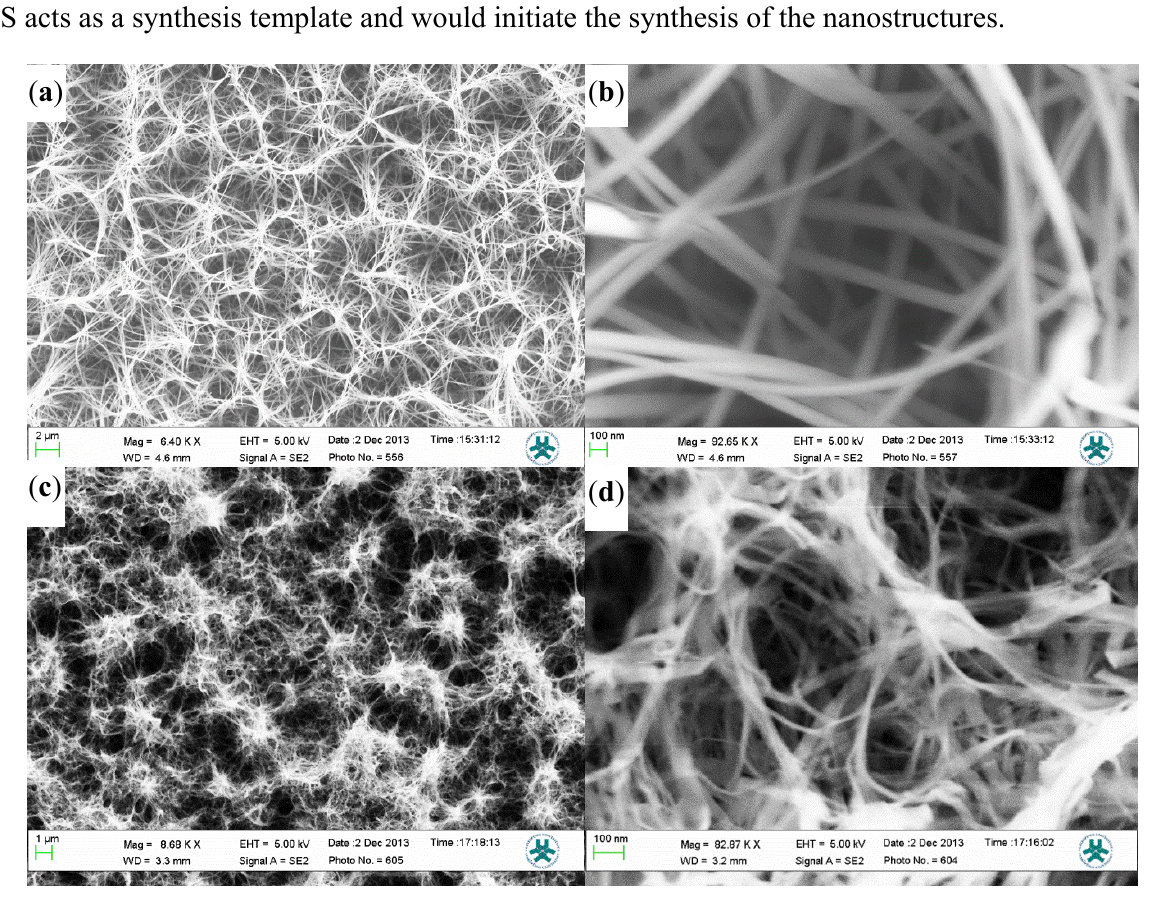
Figure 1. SEM images of ( a , b ) Co 3 O 4 wire-like nanostructure synthesized without the SDS; In ( c , d ) Co 3 O 4 cotton like-nanostructures synthesized with 10 mM SDS is shown. X-ray powder diffraction (XRD) pattern of the Co 3 O 4 nanostructures is shown in Figure